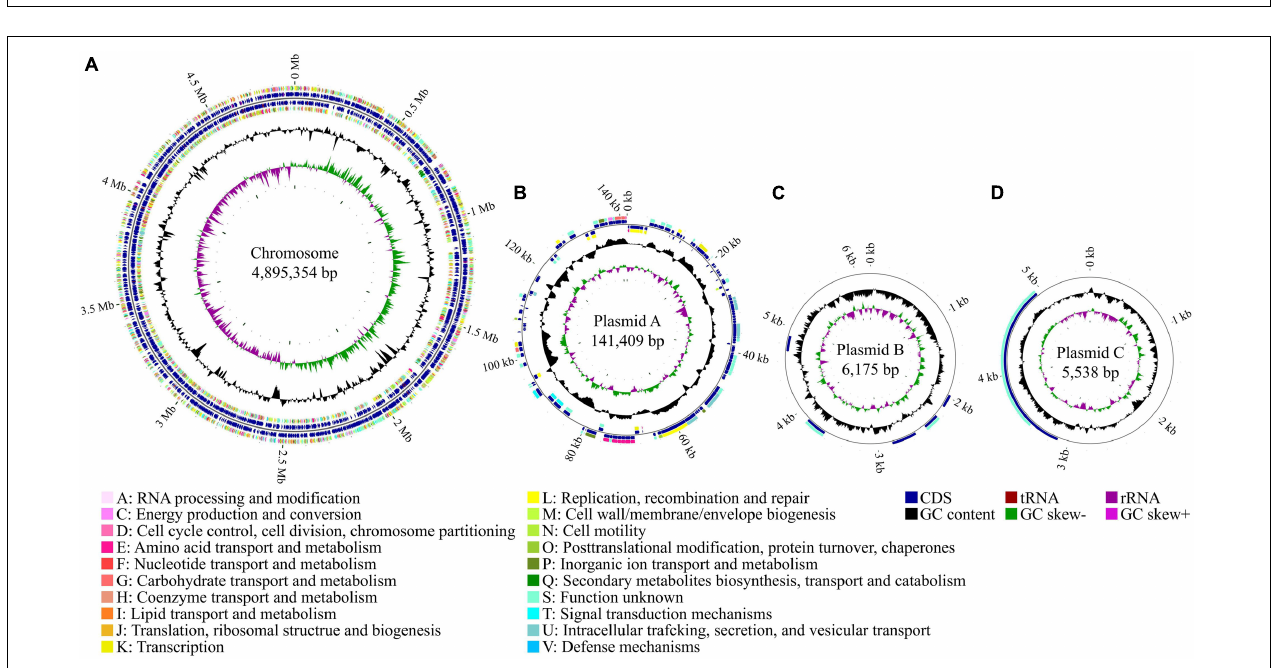
FIGURE 4 | Circular maps of strain Pa82 genome. (A) Chromosome; (B) Plasmid A; (C) Plasmid B; (D) Plasmid C. The distribution of circles from inside to outside, circle 1, GC skew (green indicates a region with G content greater than C content; purple indicates a region with G content less than C content); circle 2, GC content (outward means above the average GC content of the whole genome; inward means below the average GC content of the whole genome); circles 3 and 6, CDS on the reverse and forward strands were annotated by Clusters of Orthologous Groups (COG) database (different colors represent different COG functional categories); circles 4 and 5, CDS, tRNA and rRNA on the reverse and forward strands; circle 7, scale marks of the genome size.